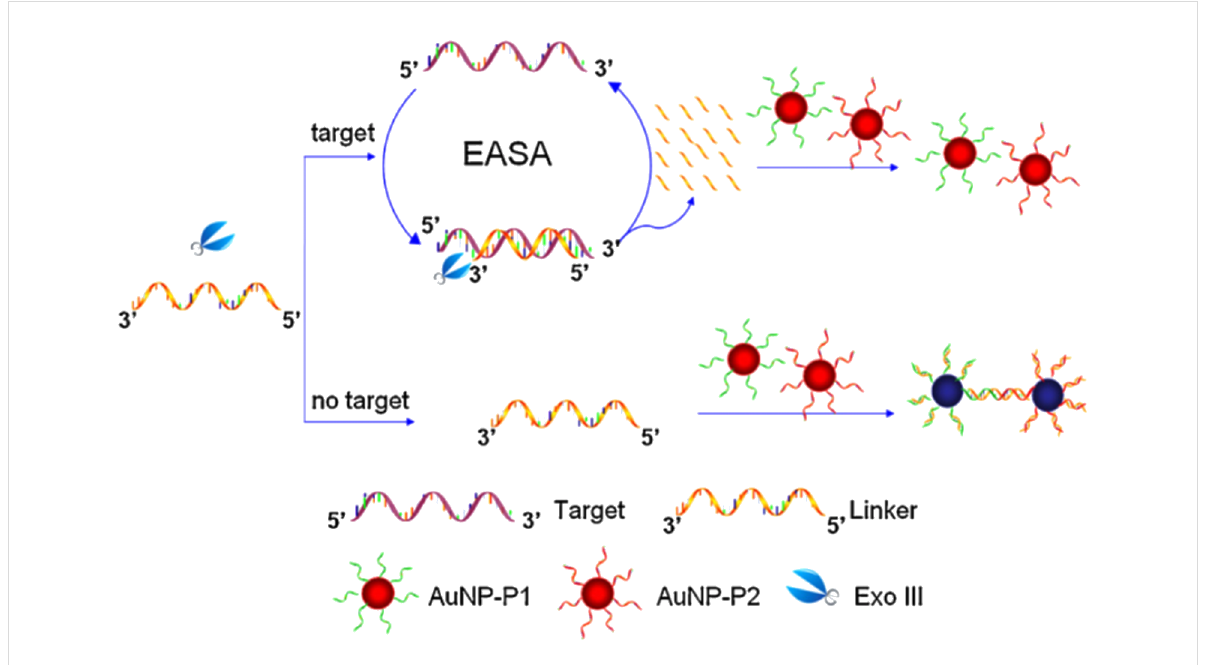
Figure 7: Working principle of EASA for the colorimetric detection of DNA mismatches. The consumption of a large amount of linker DNA strands by a few initial target molecules leads to the preservation of the colloidal stability of gold nanoparticles. In the absence of a target, the intact linker DNA hybridizes with Au@DNA leading to a gradual color change. Reprinted with permission from [108], copyright 2011 Elsevier.